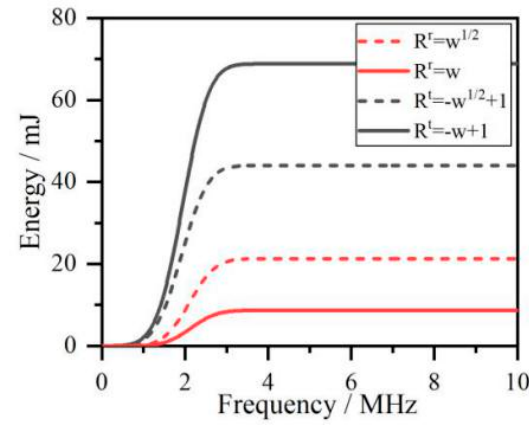
Figure 4. The energy distribution of the acoustic signals.